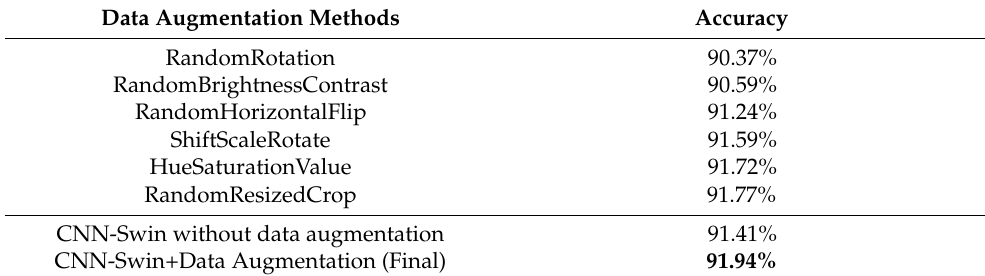
Table 7. Performance comparison of different data augmentations in CNN-Swin model.